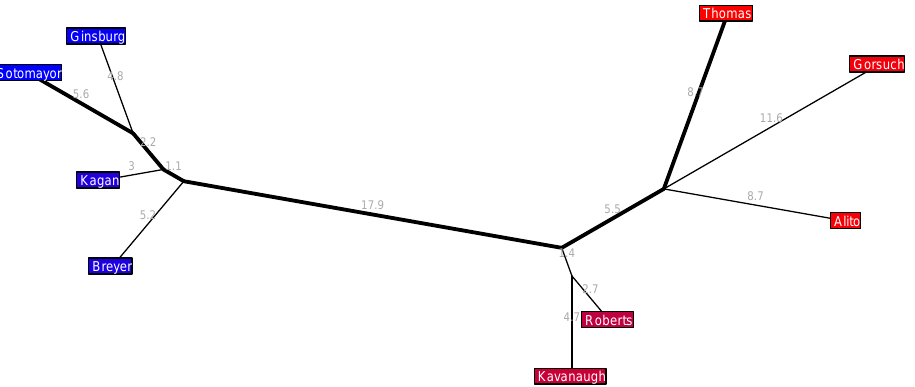
Figure 1. One-dimensional ideal point estimation for the 2018–2019 Court provided by multidimen- sional scaling (MDS).